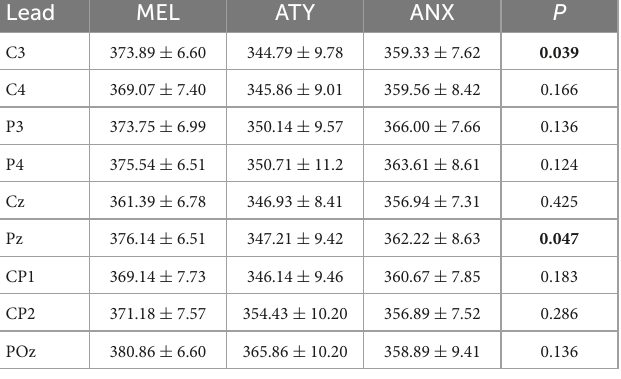
TABLE 3 Comparison of latency of baseline auditory P300 task.